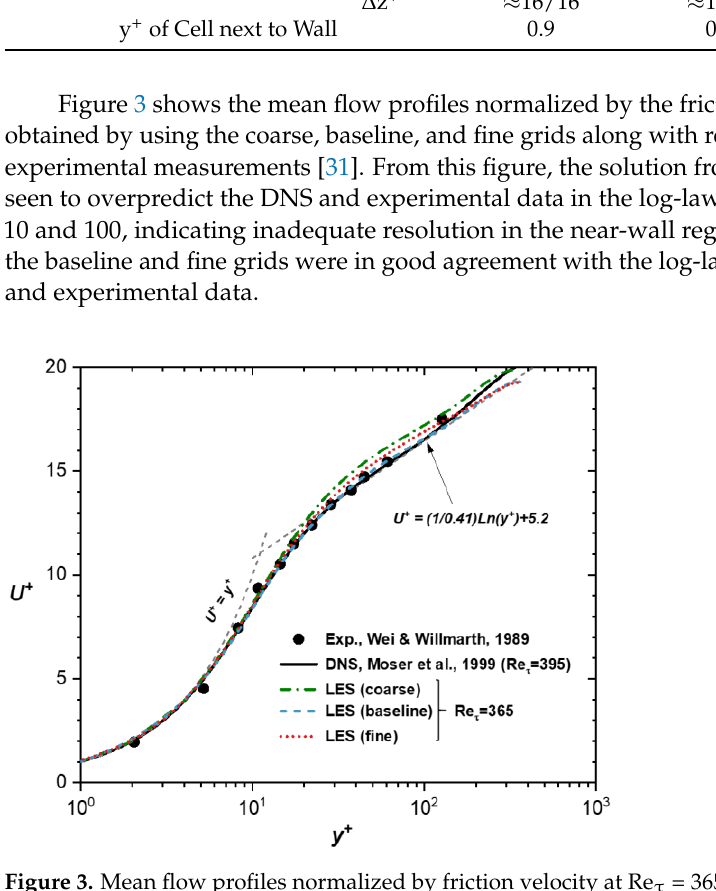
Figure 3. Mean flow profiles normalized by friction velocity at Re τ = 365.